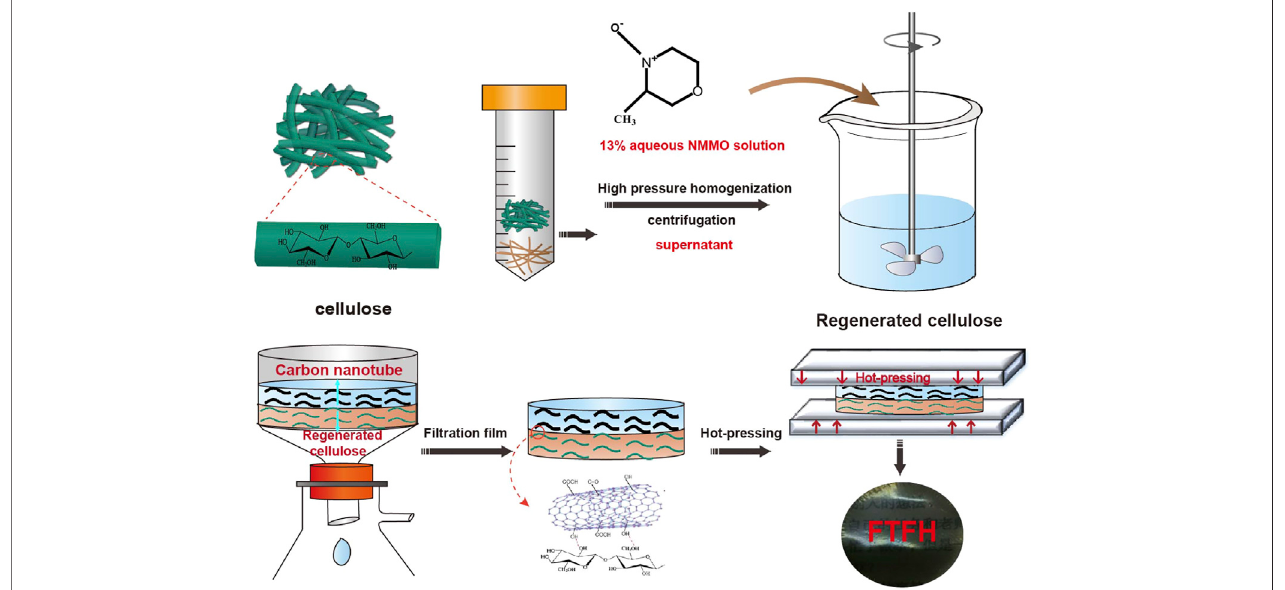
FIGURE 1 | Schematic illustration of the fabrication process for the FTFHs.